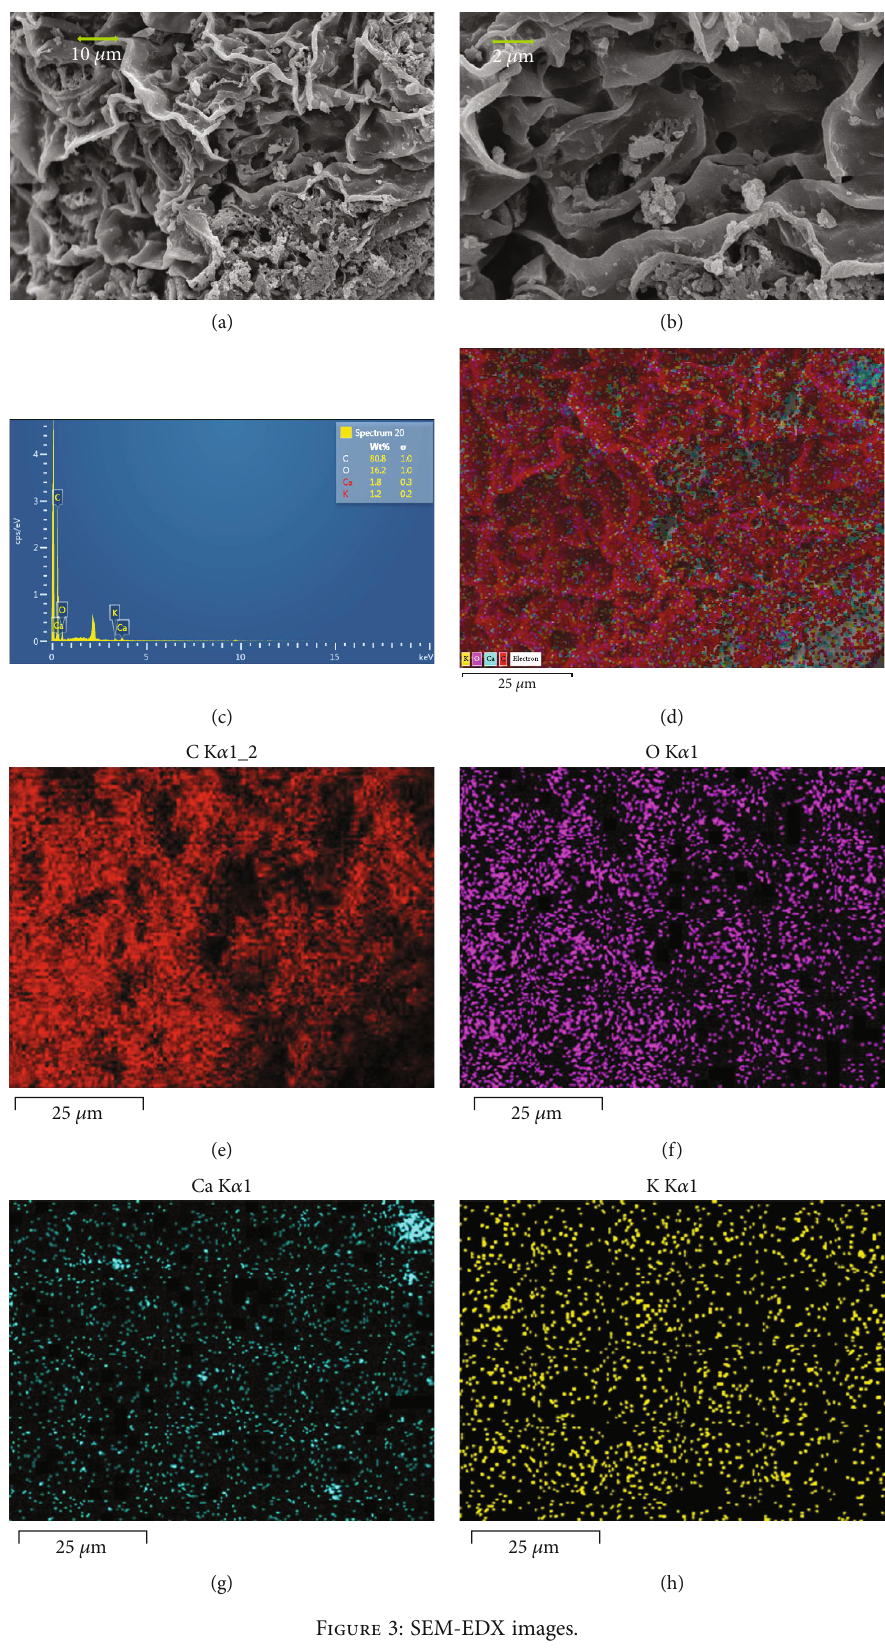
Figure 3: SEM-EDX